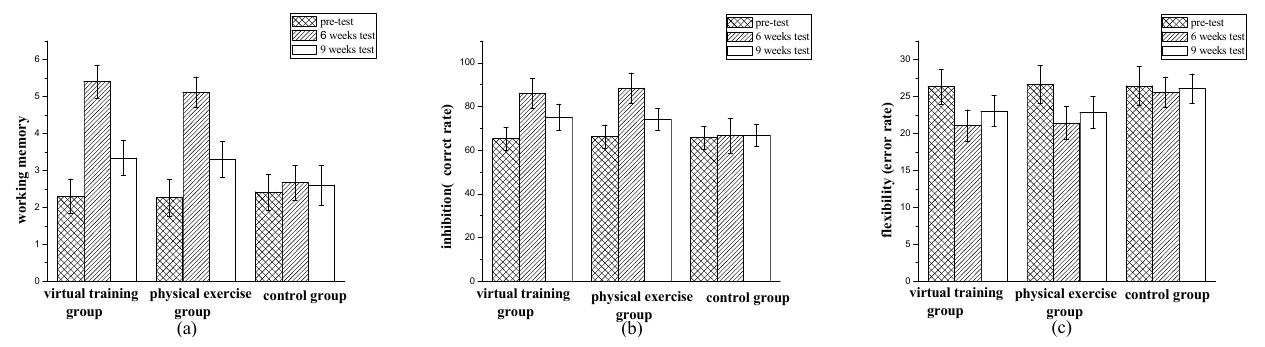
Figure 3. Three core functions of executive function: ( a ) working memory; ( b ) inhibition (correct rate); ( c ) flexibility (error rate).